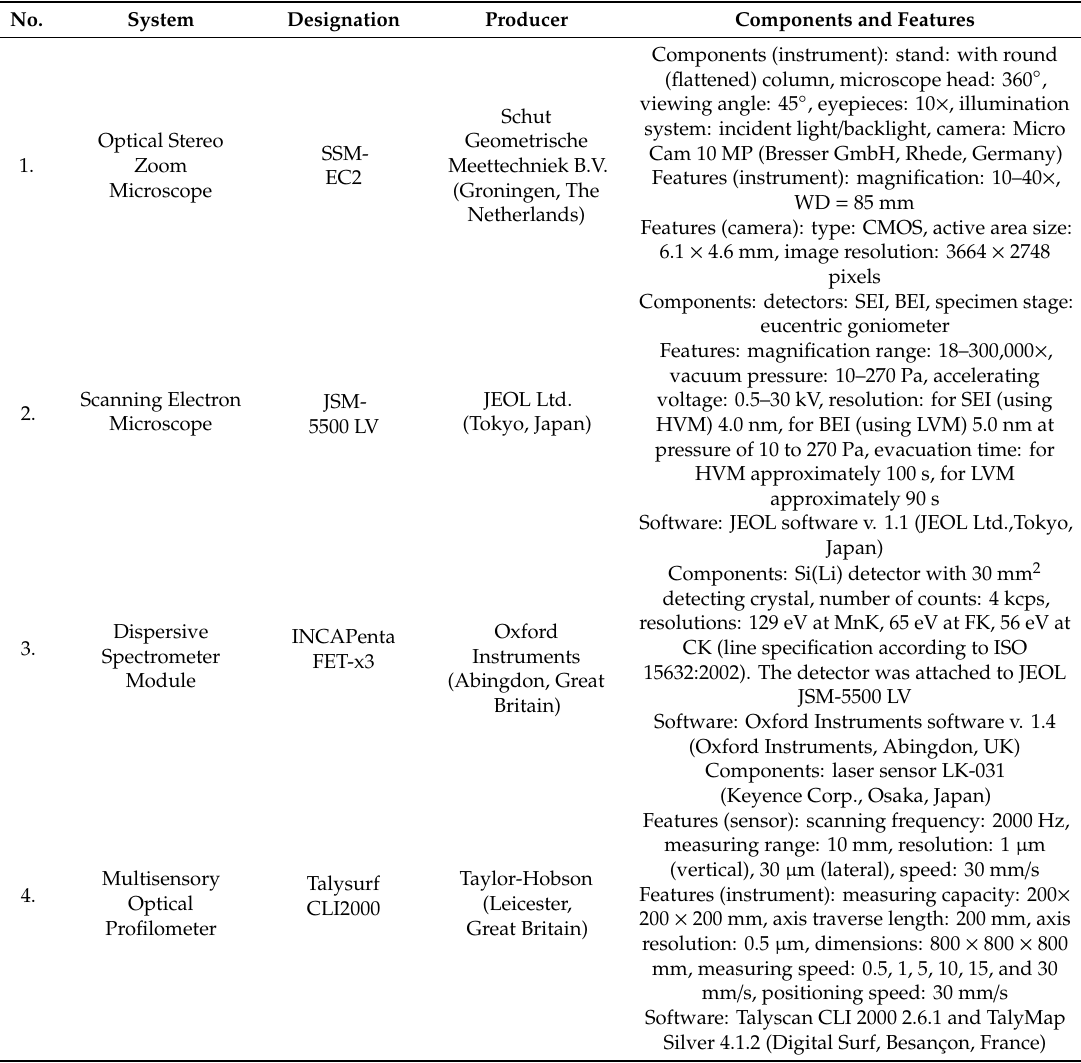
Table 4. The observation–measurement instruments used in the experimental